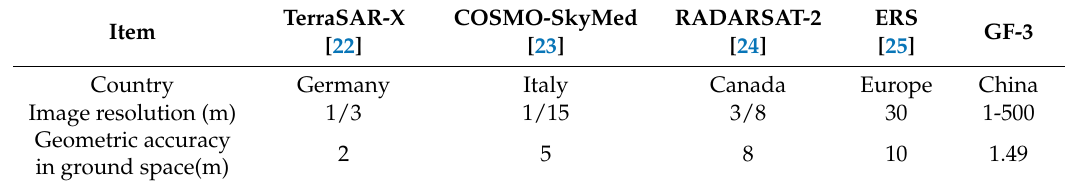
Table 4. Table of ortho-rectification accuracy comparison among the five GF-3 satellite imaging modes . Table 5. Comparison between the accuracy (RMSE) of GF-3 and other